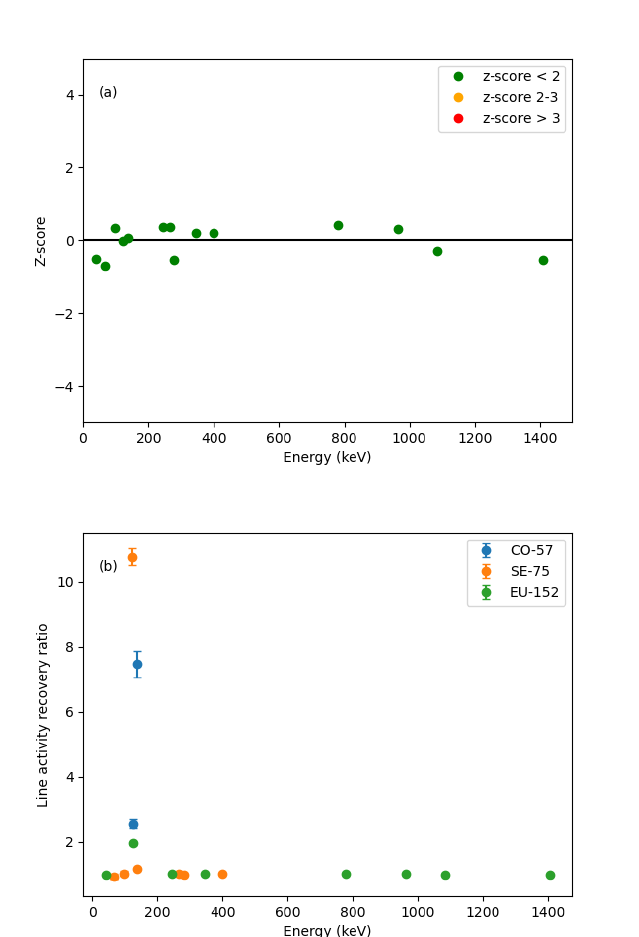
Figure 1, The Peak Area recovery z-score (a) and Line activity ratio (b) for the interference consisting of Co-57, Se-75, and Eu-152.